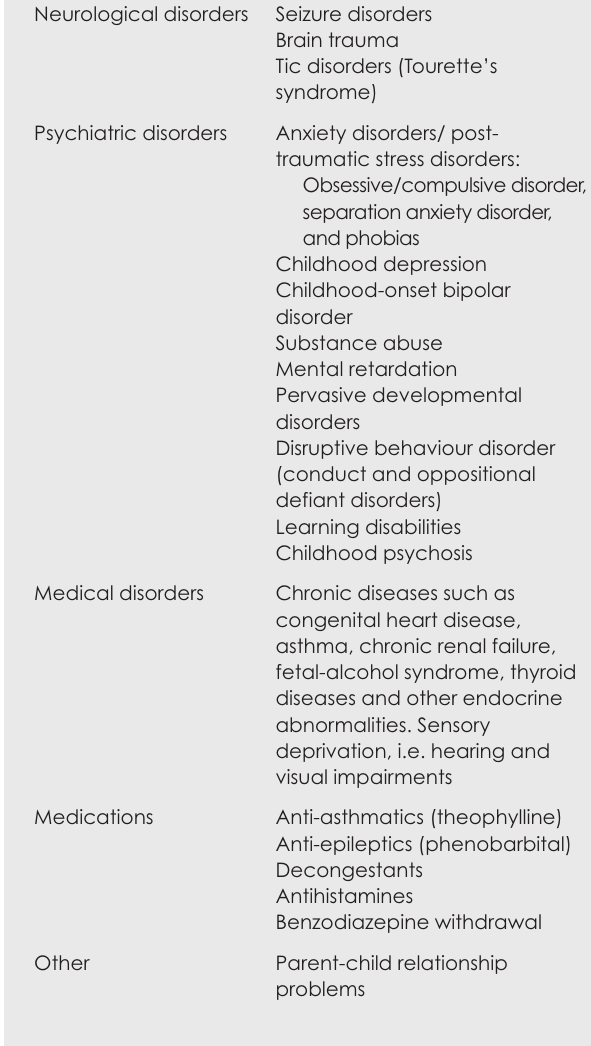
Table I. Summary of conditions that mimic co-morbid